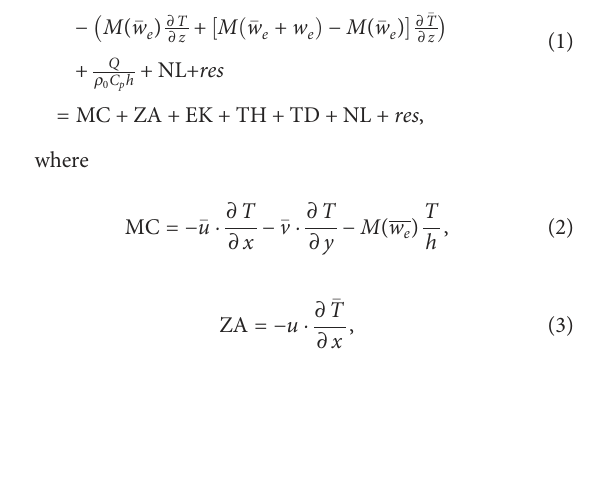
TABLE 1 List of the CMIP5 models used in this study. No. Model Modeling